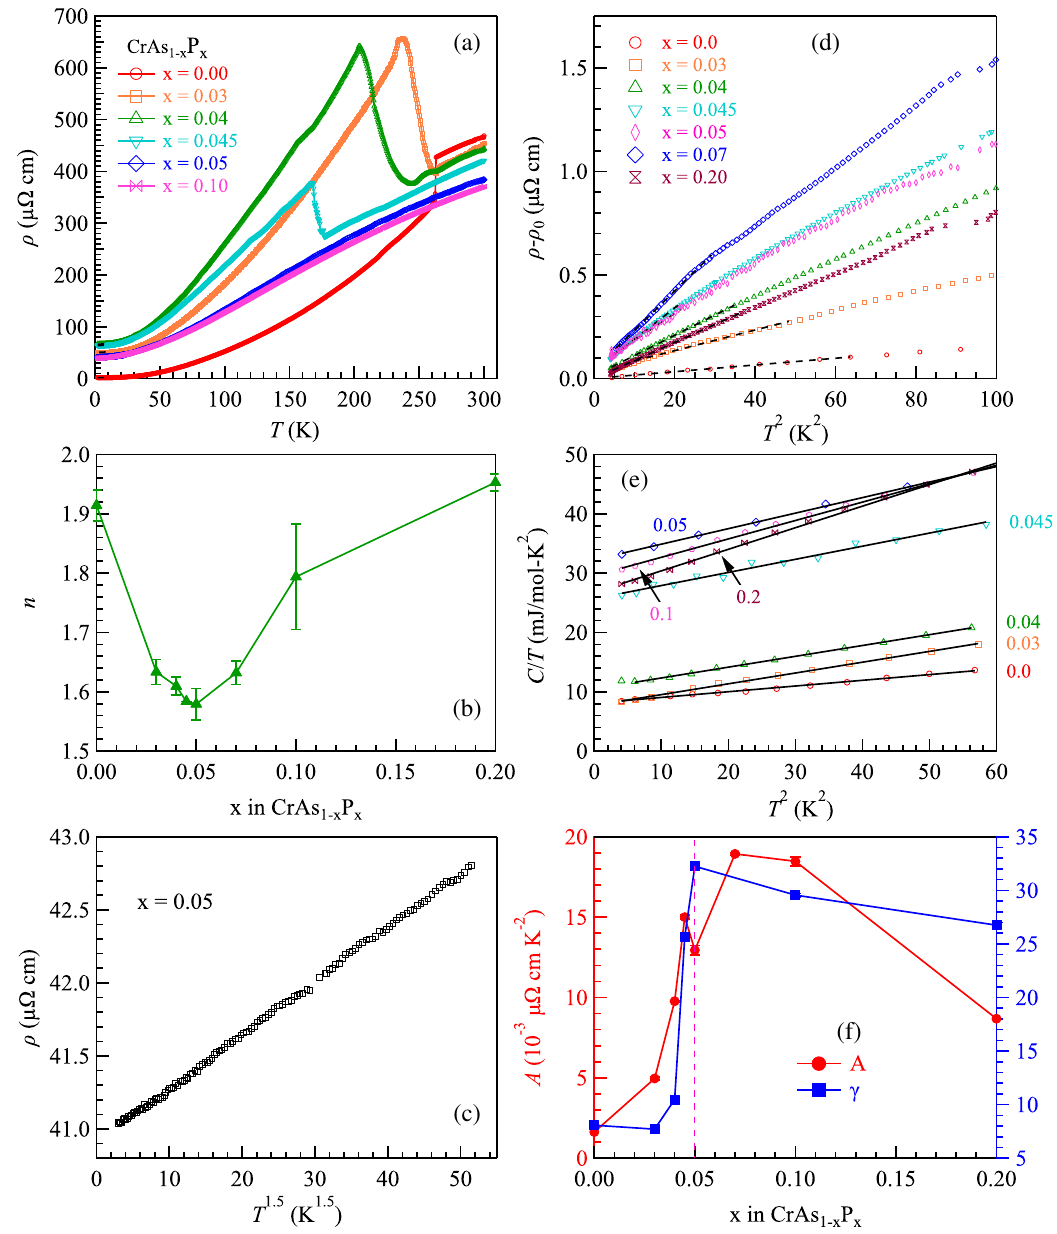
FIG. 6. (a) Temperature dependence of resistivity ρ ð T Þ for CrAs 1 − þ BT n and the obtained exponent n as a function of x is given in (b). (c) A plot of ρ vs T 1 . 5 for an x ¼ 0 . 05 sample illustrating ρ ð T Þ ¼ ρ 0 a nice linear (nFL) behavior. (d) ( ρ - ρ 0 ) vs T 2 and (e) C=T vs T 2 plots for CrAs 1 − coefficient A and the electronic specific-heat coefficient γ were extracted, and they are displayed in (f) as a function of x